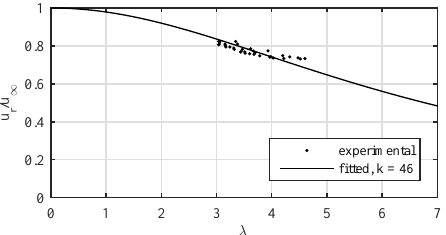
Figure 2. Wake speed measurements re-computed as flow speed at turbine and fitted